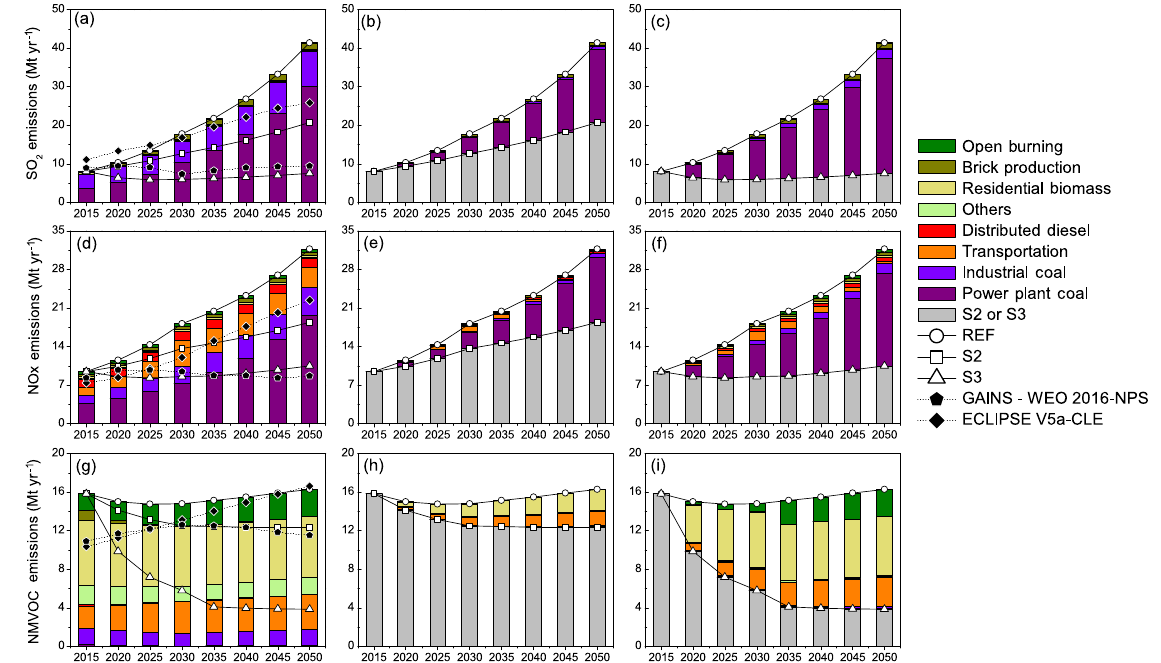
Figure 3. Sectoral emission of fine (a) SO 2 , (d) NO x and (g) NMVOCs under the three scenarios, for 2015–2030 (column 1). Differences of higher efficiency/emission control scenarios from reference (REF & S2) are shown in column 2 (b, e, h) and column 3 (c, f, i) . Emissions from ECLIPSE V5a-CLE and GAINS-WEO2016-NPS are shown for